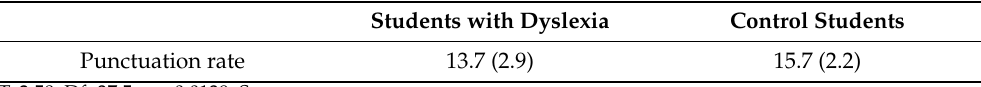
Table 4. Punctuation rate in both groups (Welch test).